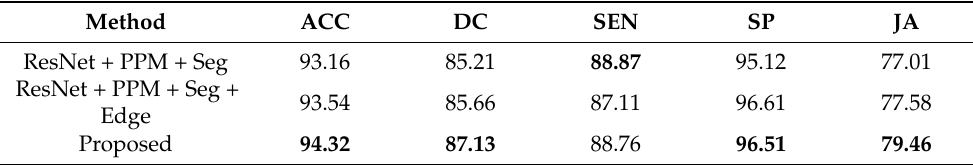
Table 3. Ablation study of the proposed method .